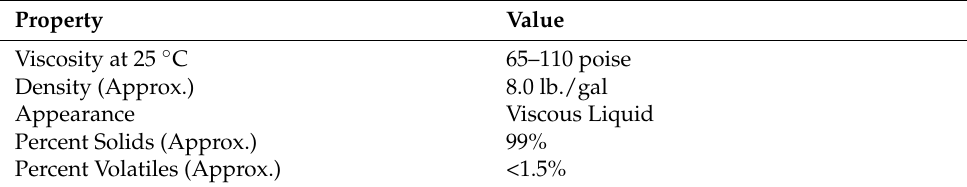
Table 2. Characteristics of used thermochromic UV screen printing